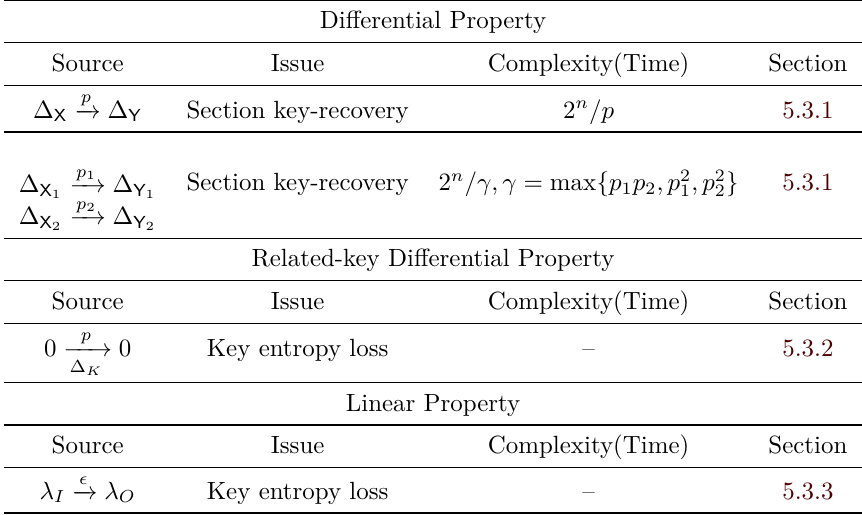
Table 5: Summary of attacks on ACPKM instantiated with a weak block